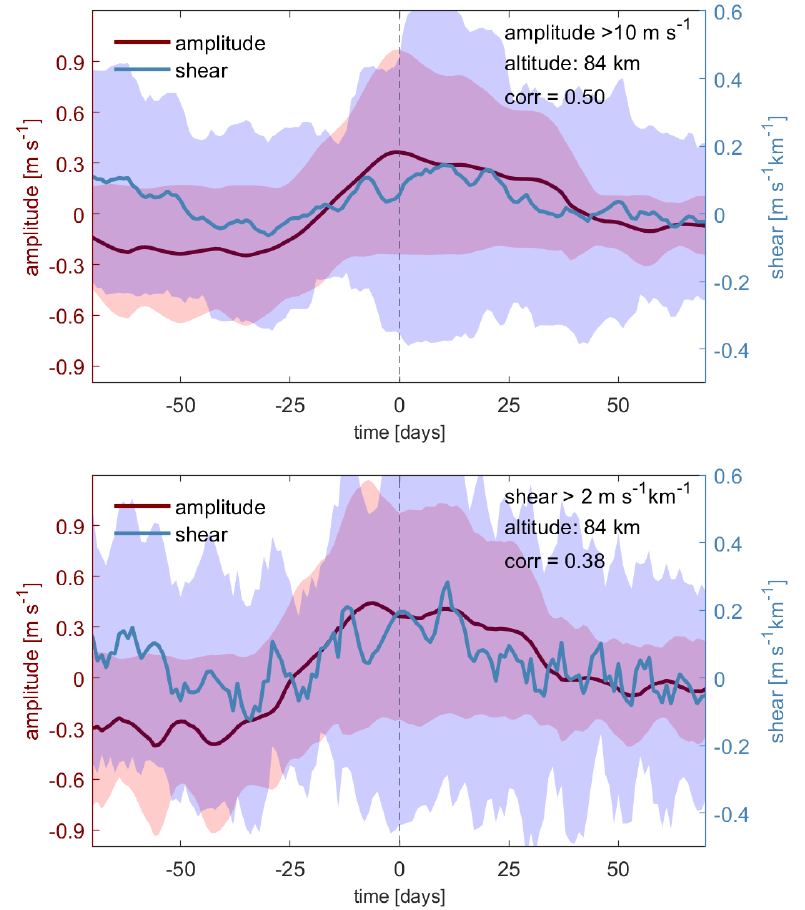
Figure 11. The mean of the anomalous vertical wind shear from the zonal wind (blue line) and the total Q16DW amplitudes (red line) from 70 d before the central day to 70 d after the central day at 84 km, along with the standard error (shading). Top panel: central days are identified when the Q16DW amplitude > 10 m s − 1 . Bottom panel: central days are identified when wind shear > 2 m s − 1 km − 1 during the winter (November–March).